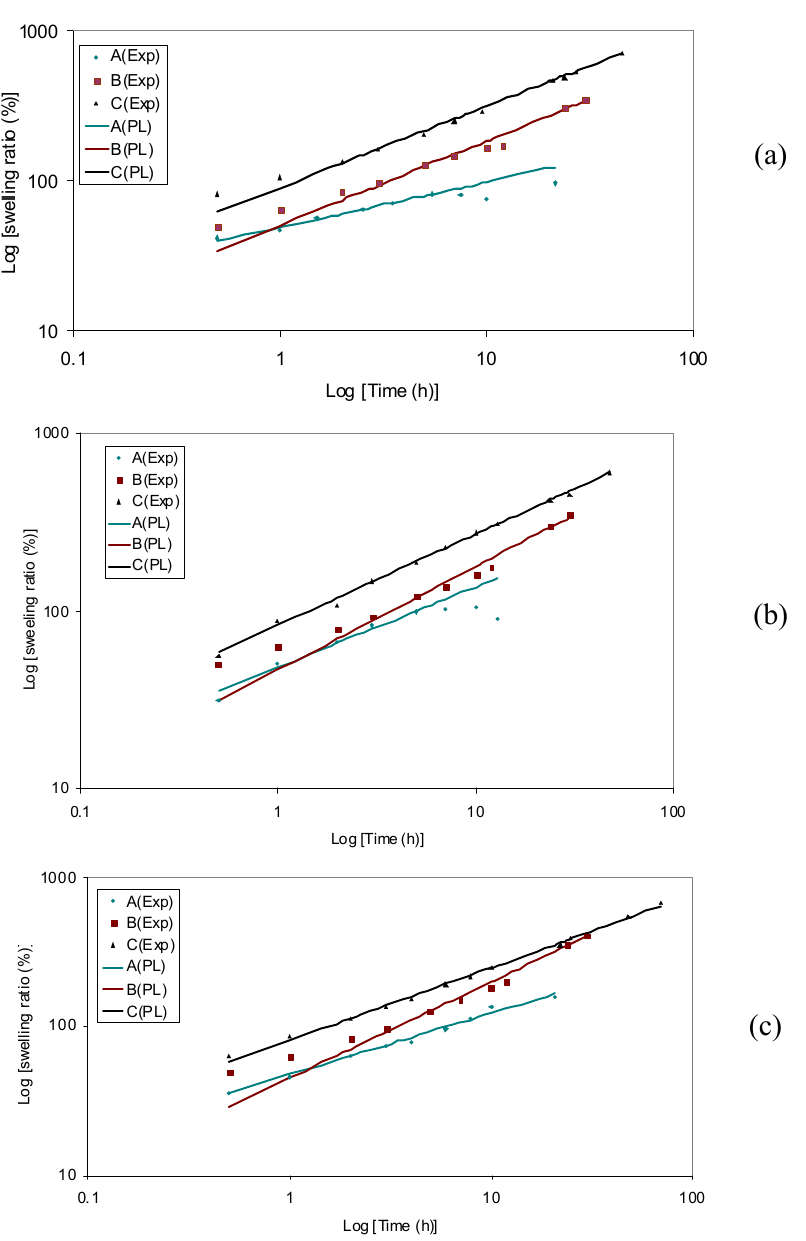
Figure 23. Experimental data (Exp) and power law profiles (PL) defining fluid uptake and swelling ratio for HPMC tablets in: ( a ) water at 37 °C; ( b ) SGF at 37 °C; ( c ) SIF at 37